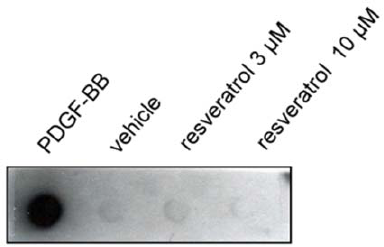
Figure 4. Resveratrol did not directly interact with PDGF-BB in dot binding assay. Human recombinant PDGF-BB, phosphate buffer saline (PBS) and the indicated concentrations of resveratrol were applied onto the nitrocellulose (NC) membrane. The membrane was incubated with PDGF-BB in PBS and then developed by probing with Ab directed against PDGF-BB. The results presented are representative of four independent experiments.